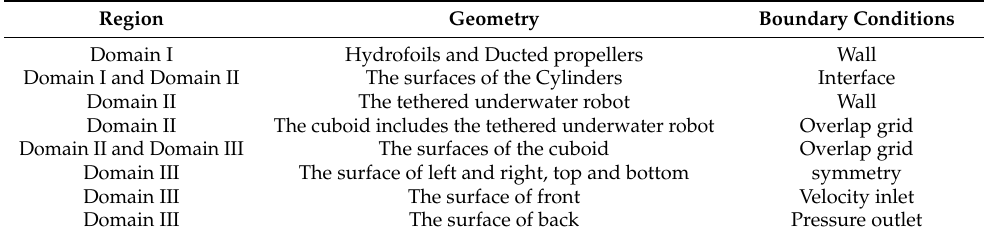
Table 2. Boundary conditions of the underwater robot.